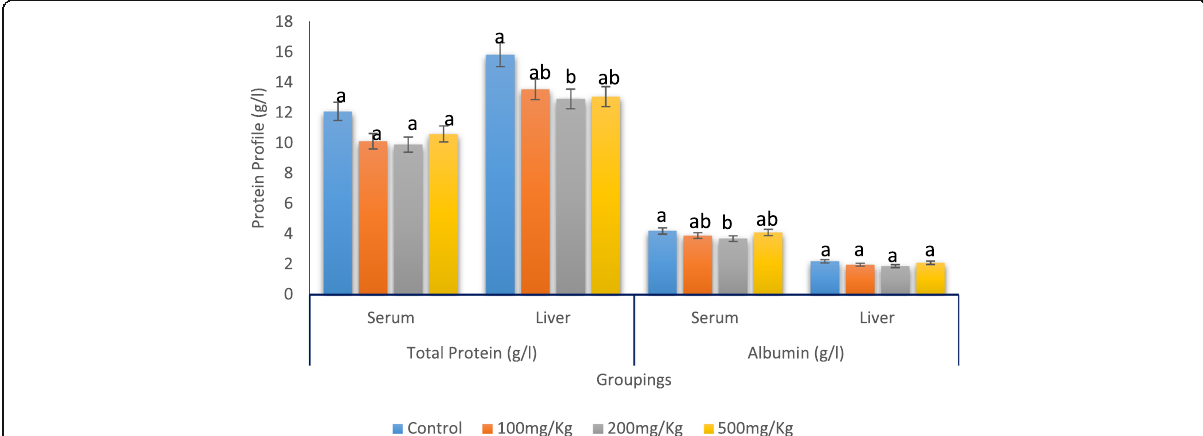
Fig. 4 Effect of Dennettia tripetala on Serum and Tissue Protein